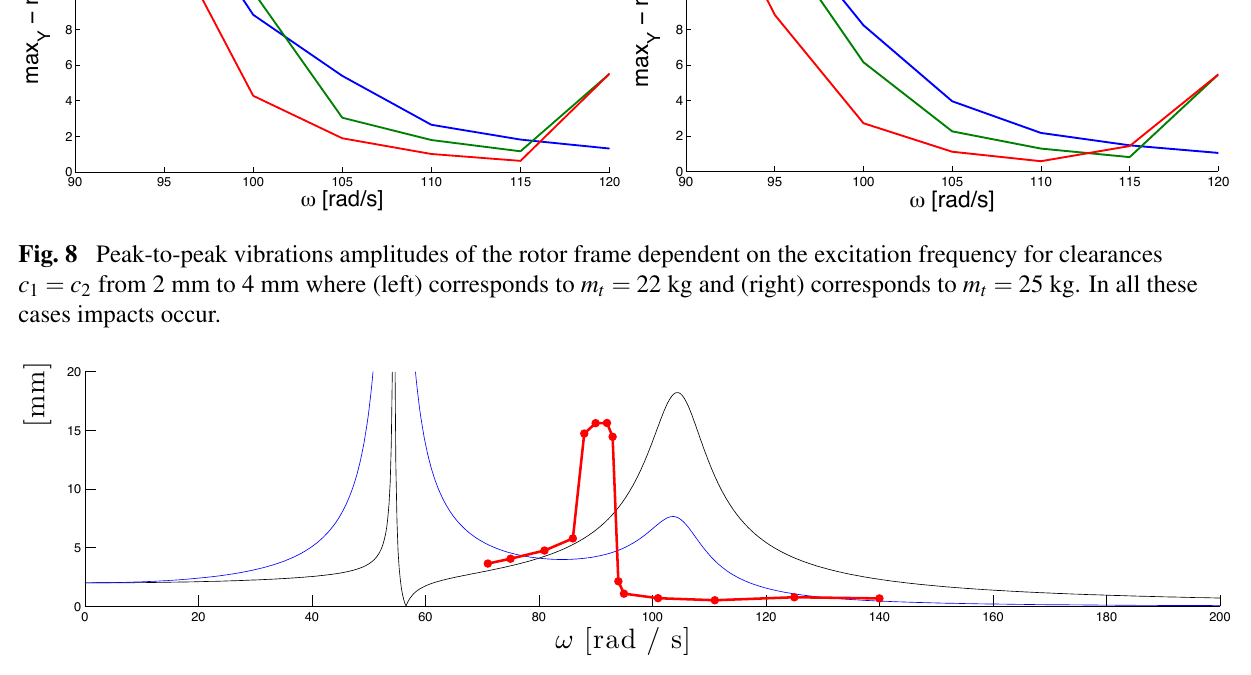
Fig. 9 Black and blue: the dependence of the peak-to-peak vibration amplitude of the rotor frame and impact element, respectively, on angular frequency of excitation of the baseplate for unlimited movement of the impact body; red: the dependence of the peak-to-peak vibration amplitude of the rotor frame on angular frequency of excitation of the baseplate for the movement of the impact body limited by clearances; for parameters m t = 25 kg and b t = 0 N s m − 1